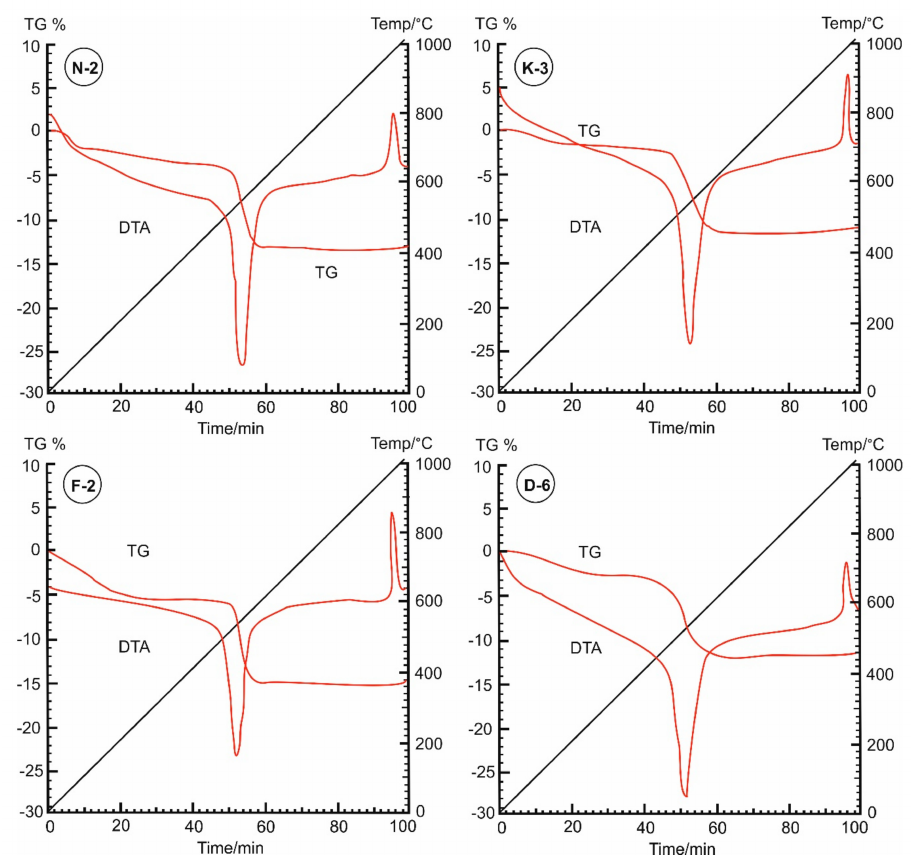
Figure 7. Dehydration-dehydroxylation thermograms (TG%) and di ff erential thermal analysis (DTA) curves of the studied kaolin powder samples (25–400 ◦